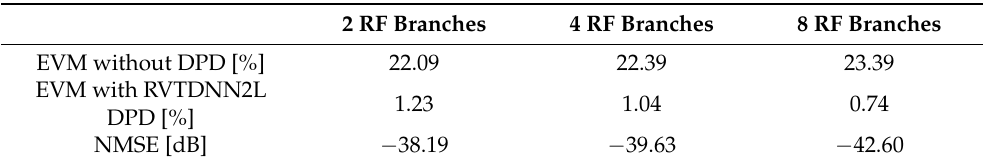
Figure 5. Power Spectral Density of the FC HBF mMIMO using 2,4 and 8 RF branches. Table 3. Performance of RVTDNN2L DPD architecture for 64 × 64 FC HBF MIMO system with 2, 4 and 8 RF branches.